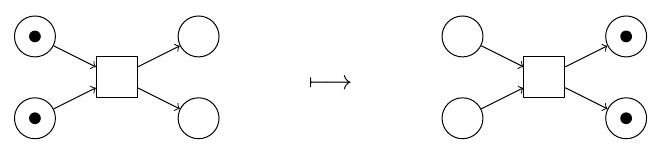
Figure 1 . An enabled transition and its (cid:12)ring.